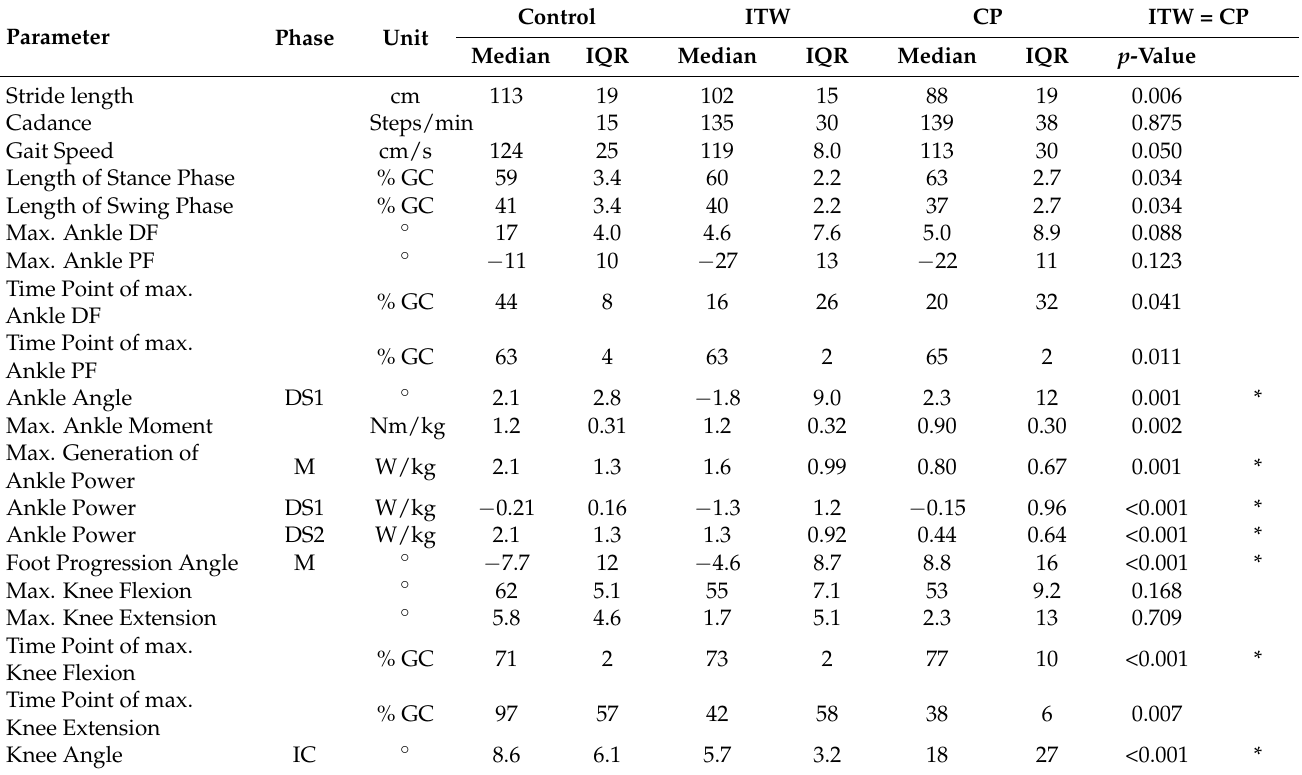
Table 2. Description of kinematic and kinetic gait measurements and pairwise comparison between ITW and